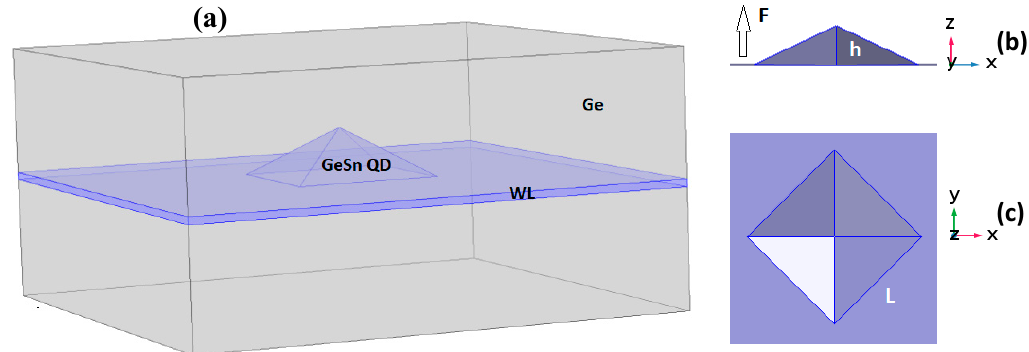
Figure 1. Schematic sketch of the pyramidal shaped self-assembled GeSn QD with 1 nm thick wetting layer (WL): ( a ) 3D projection of the pyramidal QD with wetting layer, ( b ) cross-sectional view (ZX) showing the QD height and the direction of the external electric field, ( c ) plane view (XY).